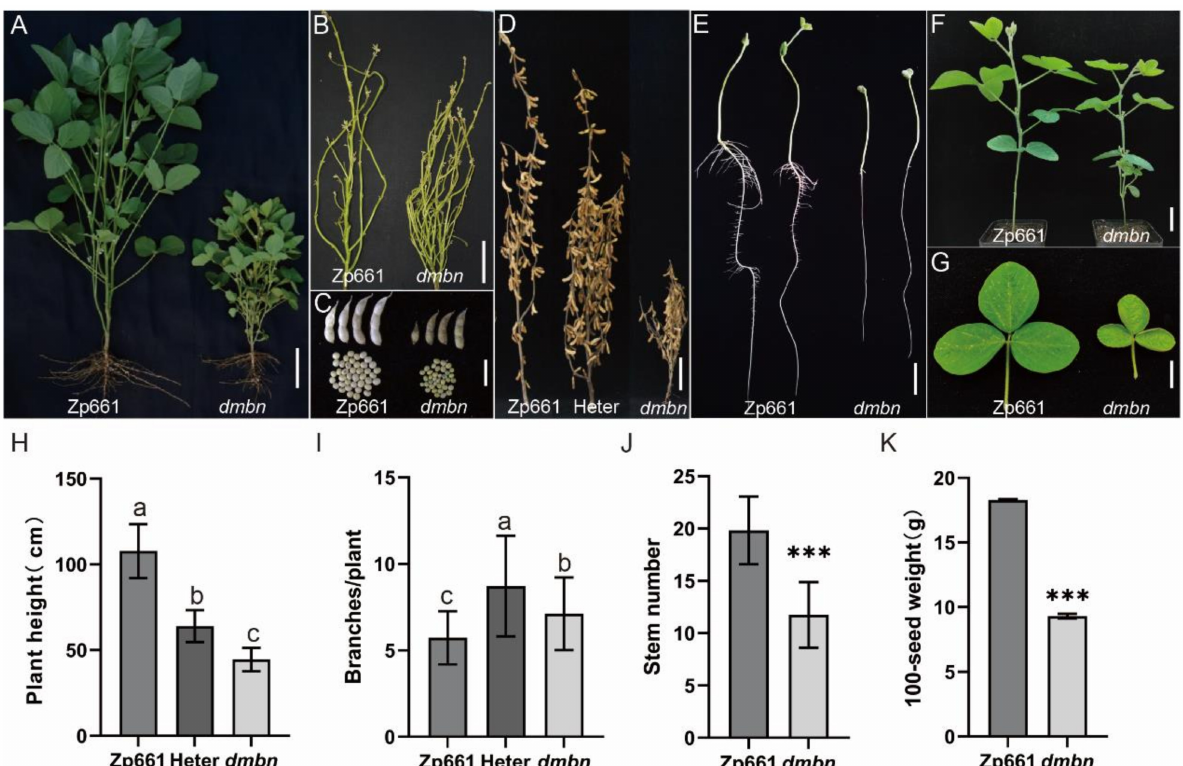
Figure 1. Phenotypic characterization of the dmbn mutant and Zhongpin661 (Zp661). ( A , B ) Phe- notypes of Zp661 and dmbn at vegetative stage; bar, 10 cm. ( C ) Pods and seeds of mature soybean of Zp661 and dmbn ; bar, 3 cm. ( D ) Phenotypes of Zp661, dmbn , and a heterozygous plant at the mature stage; bar, 10 cm. ( E ) Root phenotypes of Zp661 and dmbn at the seeding stage; bar, 3 cm. ( F ) Phenotypes of Zp661 and dmbn at the R5 stage; bar, 3 cm. ( G ) Leaf phenotypes at the R5 stage of Zp661 and dmbn ; bar, 3 cm. ( H , I ) Plant height and branches of Zp661, dmbn , and a heterozygous plant at maturity. Values are mean ± SD ( n = 15). ( J , K ) Stem number and 100-seed weight of Zp661 and dmbn . Student’s t -test was used for comparisons (*** p ≤